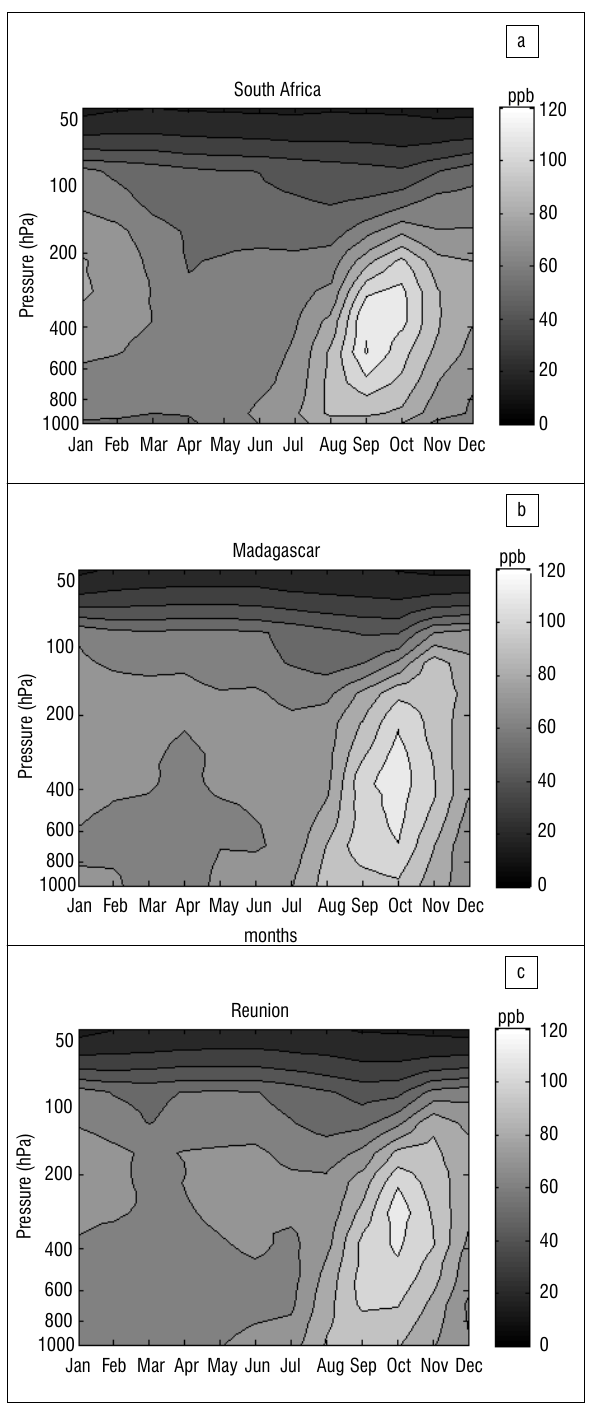
Figure 6: Seasonal distribution of CO concentration in ppb over (a) South Africa, (b) Madagascar and (c) Reunion